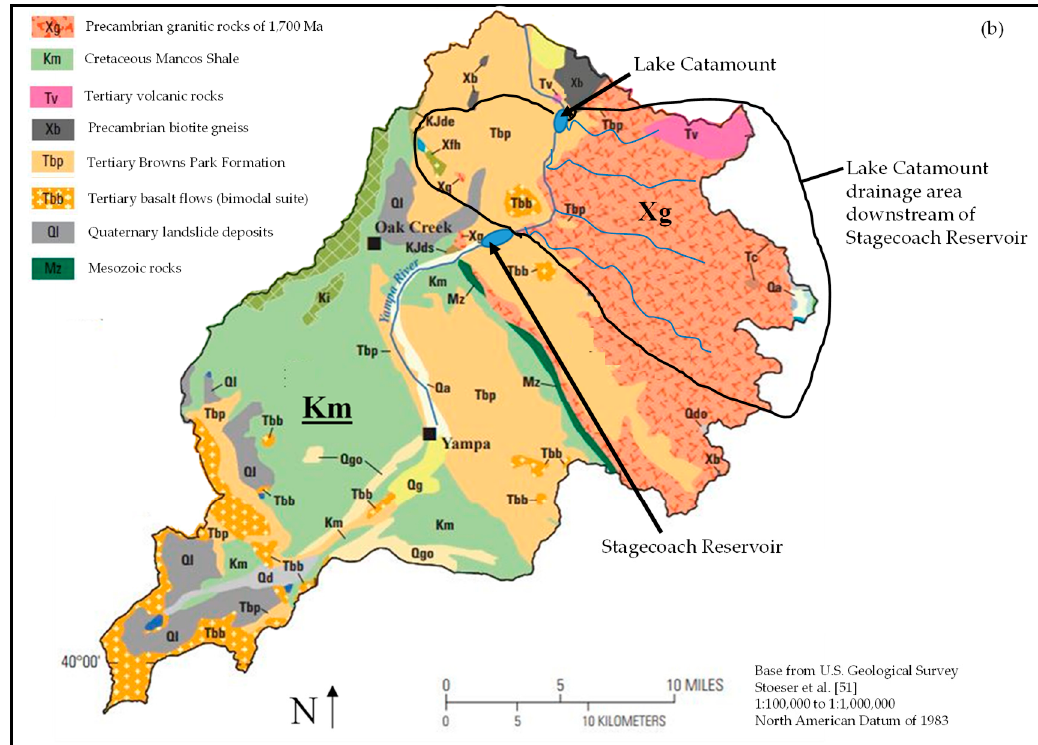
Figure 1. The study area ( a ) was located in northwest Colorado, USA between Stagecoach Reservoir and Lake Catamount. Geological differences ( b ) in the upper Yampa River Basin, Colorado (revised from Bauch et al. [50]). The Yampa River flows north from Stagecoach Reservoir to Lake Catamount. The high gradient tributaries that flow from the east into Lake Catamount and into the Yampa River between Stagecoach Reservoir and Lake Catamount have an underlying geology of Precambrian granite rocks of 1700 Ma (red area labeled Xg). The area south of Stagecoach Reservoir has lower gradient tributaries that flow over Cretaceous Mancos Shale (green area labeled Km). Definitions of other colors and abbreviations are provided in Bauch et al. [50]. Base map obtained from Stoeser et al. [53].